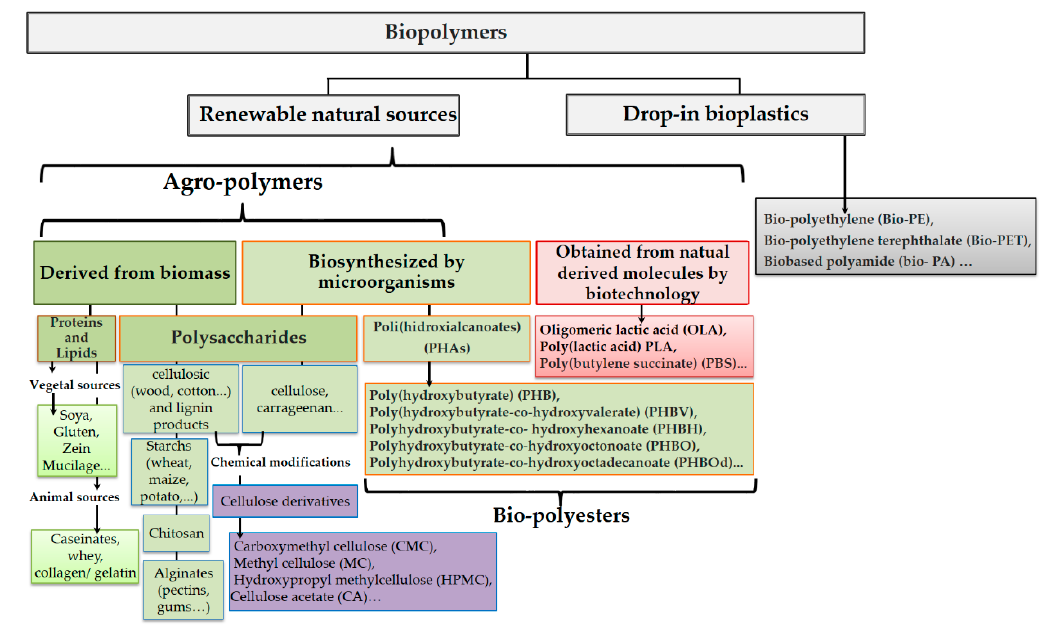
Figure 1. Classification of biobased polymers.